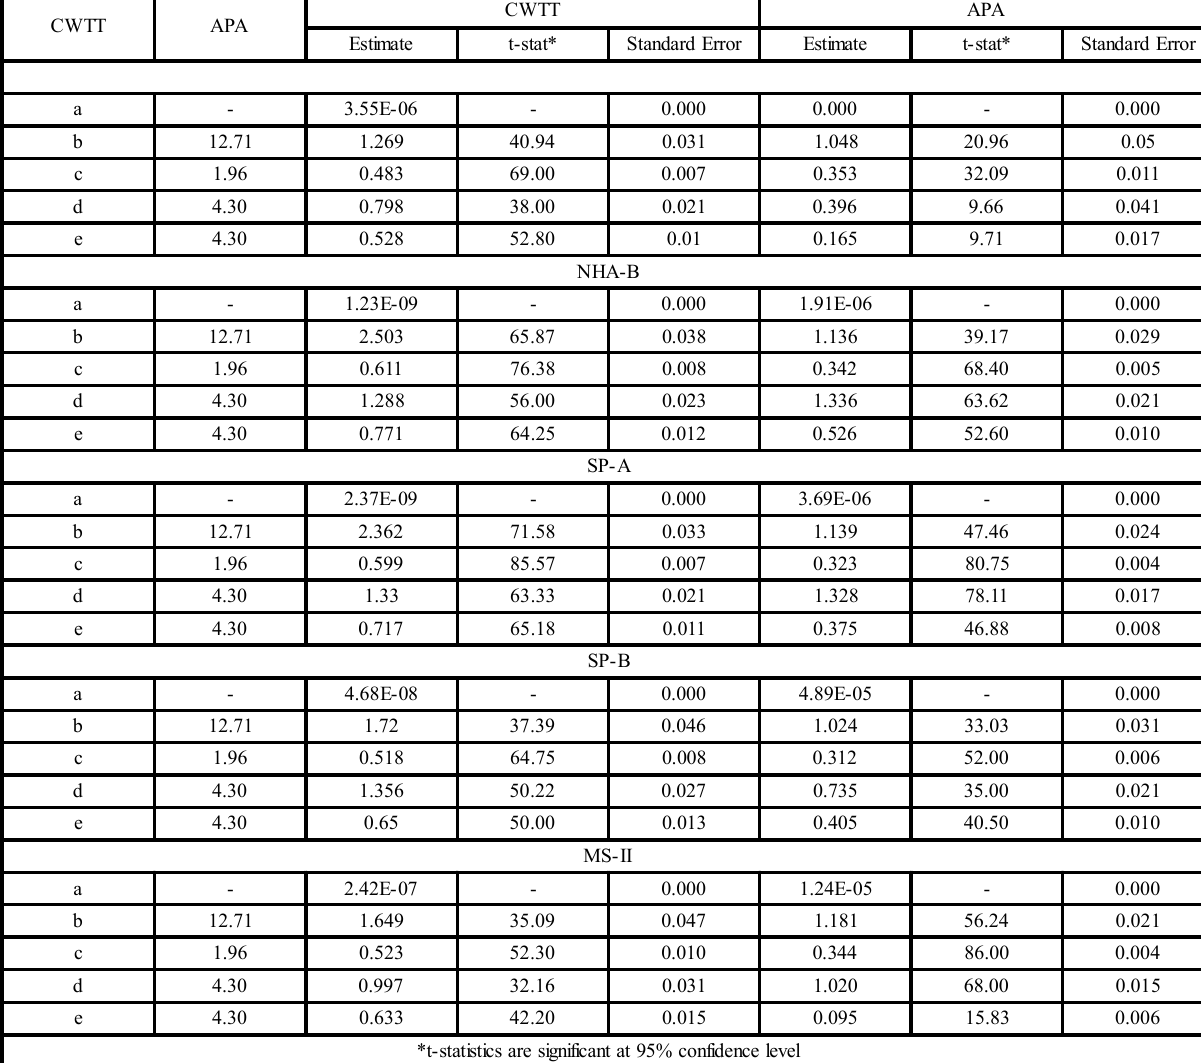
TABLE 4. PARAMETER ESTIMATES OF NON-LINEAR REGRESSION MODEL (CWTT AND